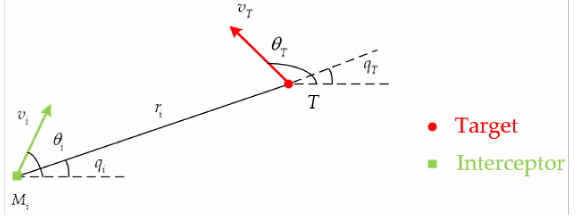
Figure 1. Planar one-to-one engagement.